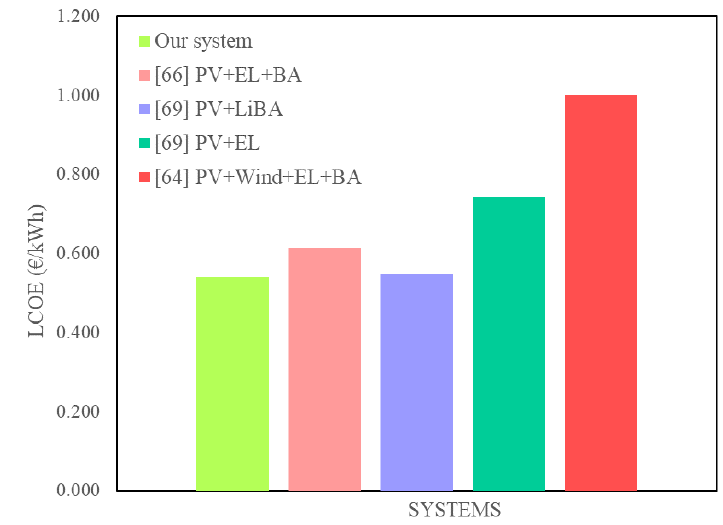
Table 3 . Equipment investment and economic parameters for both systems: the electrolyzer–fuel cell system without a battery and the conventional system (photovoltaic panel with